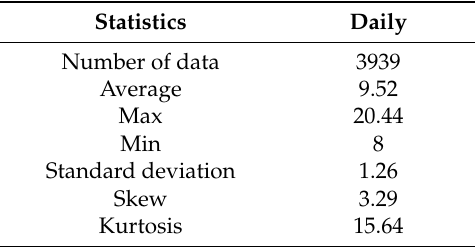
Figure 1. Time series plot of daily water level data of Kelantan River at the Guillemard Bridge station from 1 January 2000 until 13 October 2010. Table 1. Statistics for the time series of daily water level data of Kelantan River at the Guillemard Bridge station from 1 January 2000 until 13 October 2010.